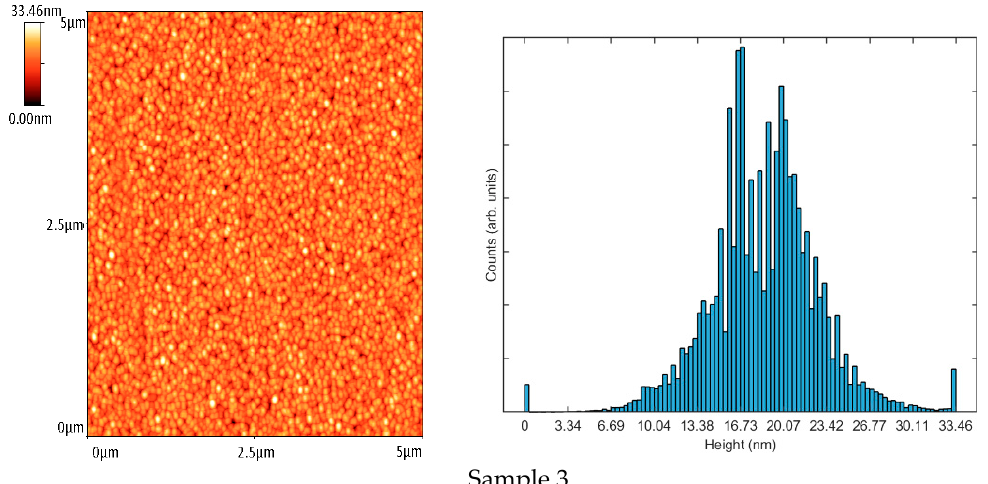
Figure 11. 2D AFM images of Samples 0–3 and their corresponding histograms.